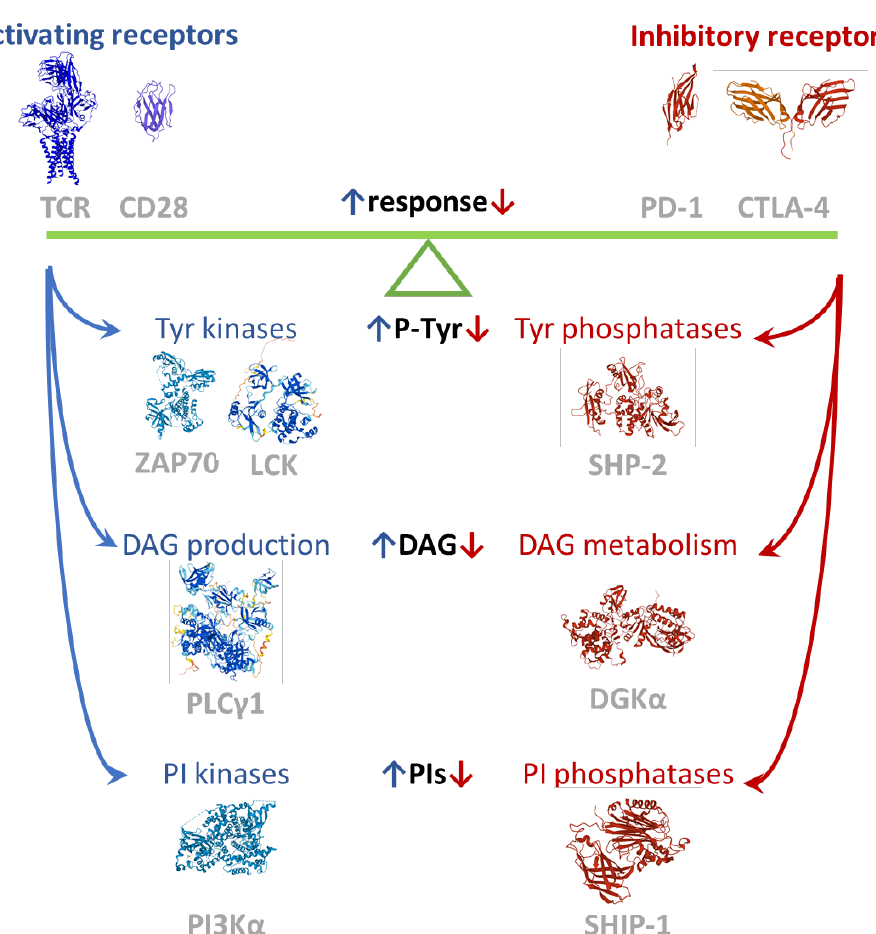
Figure 1. Balance of positive and negative signals tuning the immune response. Images created using RCSB PDB (www.rcsb.org accessed on 1 February 2022) and the Mol* application [10]. The TCR complex structure is 6JXR [11], the CTLA-4 partial dimeric structure is 3OSK [12], the ZAP70 structure is 4K2R [13], the SHP-2 structure is 2SHP [14], the SHIP-1 partial structure is 6XY7, the PD-1 extracellular domain is 3RRQ, and the CD28 extracellular is 6O8D (available in PDB, to be published). LCK, PLCΥ1, and DGKA models are from AlphaFold [15].